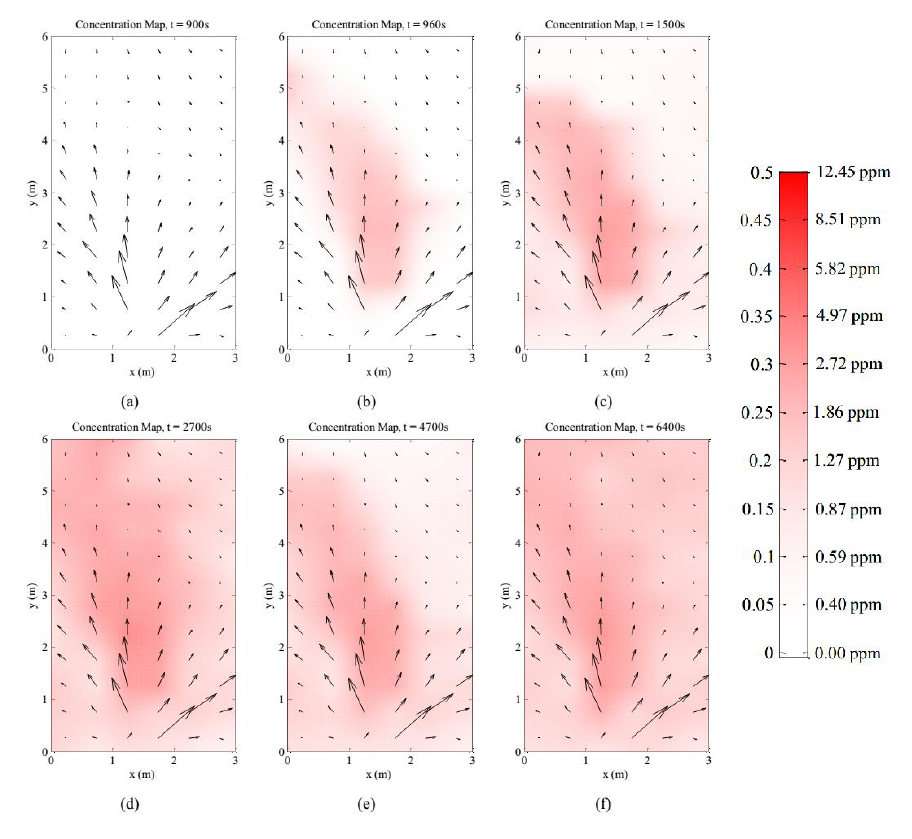
Figure 15. Snapshot of gas distribution map in testbed; ( a ) t = 900 s; ( b ) t = 960 s; ( c ) t = 1500 s; ( d ) t = 2700 s; ( e ) t = 4700 s and ( f ) t = 6400 s. The estimated ethanol concentration is described on the color scale.